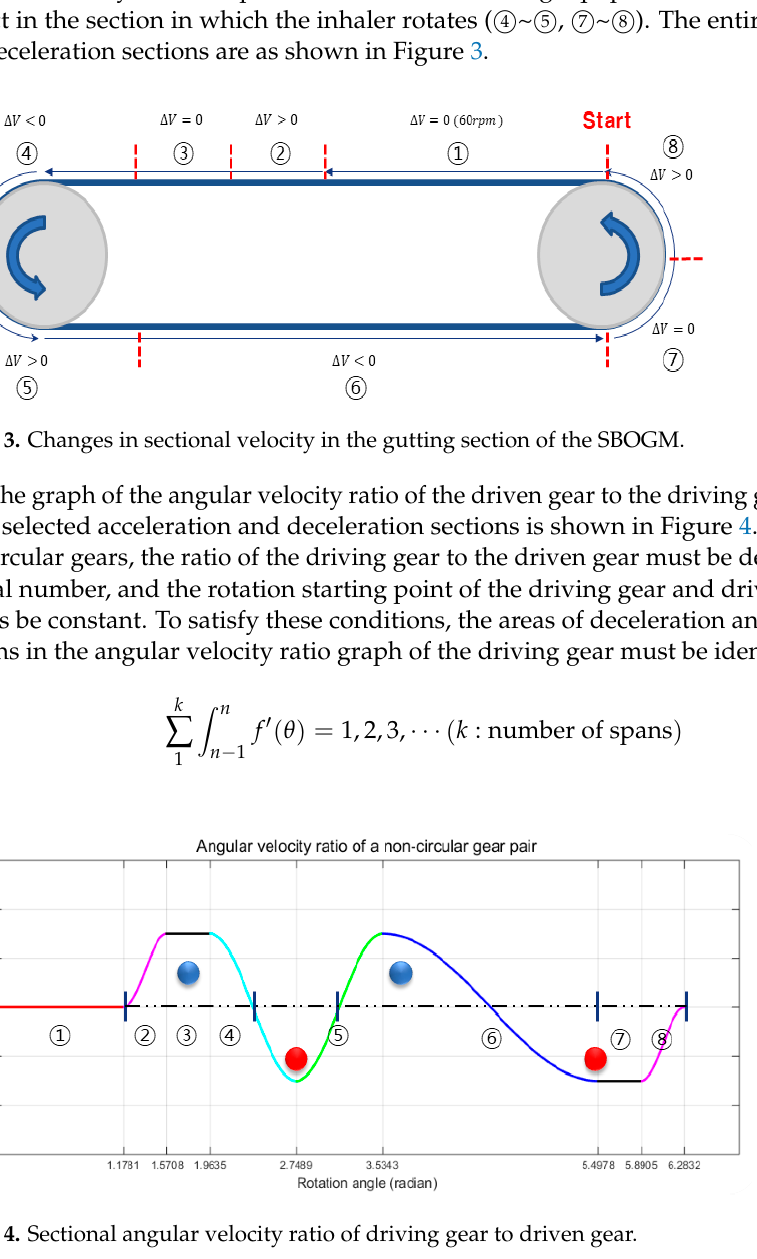
Figure 4. Sectional angular velocity ratio of driving gear to driven gear.